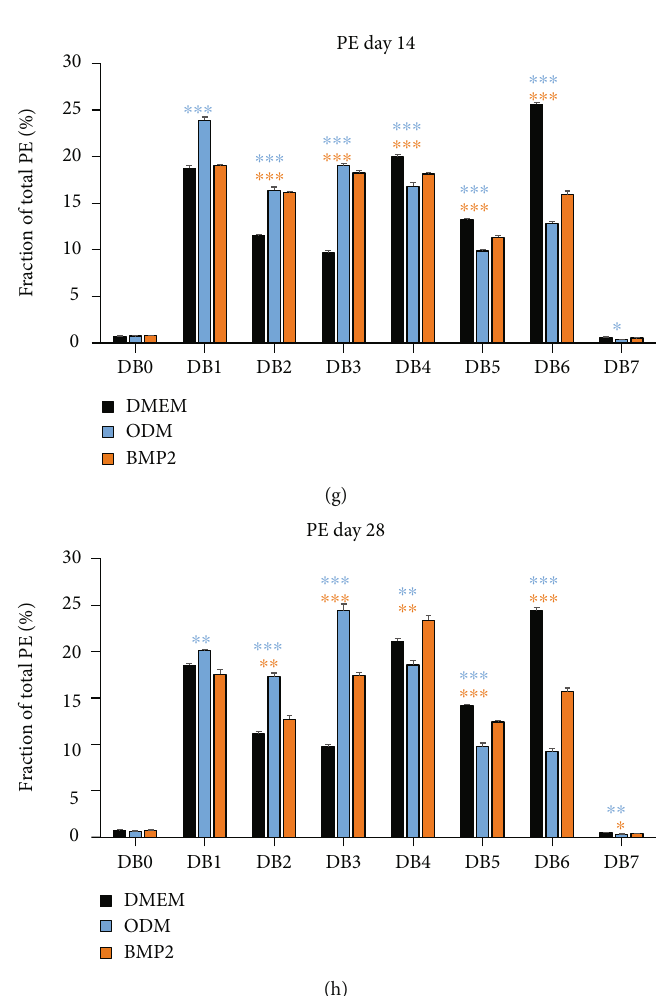
Figure 5: Regulation of phosphatidylethanolamines with di ff erent numbers of C-atoms and double bonds during osteogenic di ff erentiation of DFCs. DFCs were cultured in osteogenic di ff erentiation medium (ODM), BMP2 di ff erentiation medium, or control medium (DMEM) for one, seven, 14, and 28 days before the lipidome was analyzed by MS. This fi gure shows the regulation of phosphatidylethanolamines (PE) with di ff erent C-atom numbers at day 1 (a), day 7 (b), day 14 (c), and day 28 (d), and PEs with di ff erent numbers of double bonds (DB) at day 1 (e), day 7 (f), day 14 (g), and day 28 (h). Results are shown as means + standard deviation , and Student ’ s t -test was performed to compare di ff erentiation medium with the control medium at the same time point. ∗ p < 0 : 05 , ∗∗ p < 0 : 01 , ∗∗∗ p < 0 : 001 . Asterisks relate to the di ff erentiation medium with bars in same